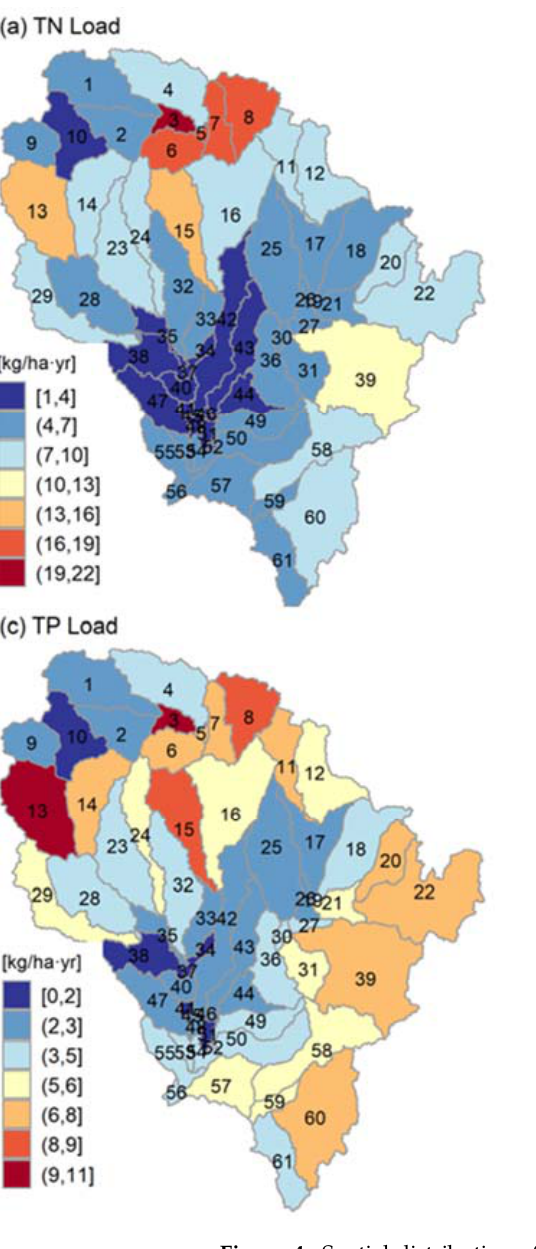
Figure 4. Spatial distribution of simulated TN ( a , b ) and TP ( c , d ) averaged over 2000–2019. Panels ( a , c ) are the annual mean load into reach from each subbasin and ( b , d ) are the mean monthly pollutant concentrations in the reach. The blue palette in ( b , d ) indicates concentrations of water quality of Class I (applicable to source water and national nature reserves, with TN ≤ 0.2 mg/L and TP ≤ 0.02 mg/L), Class II (primary protection zone for centralized drinking water, with TN ≤ 0.5 mg/L and TP ≤ 0.1 mg/L), Class III (secondary protection zone for centralized drinking water, with TN ≤ 1 mg/L and TP ≤ 0.2 mg/L), Class IV (undrinkable, applicable to general industrial water, with TN ≤ 1.5 mg/L and TP ≤ 0.3 mg/L), and Class V (undrinkable, applicable to agricultural water, with TN ≤ 2 mg/L and TP ≤ 0.4 mg/L), respectively, according to Environmental Quality Standards for Surface Water (GB3838-2002). The red palette indicates water quality inferior to Class V (i.e., TN > 2 mg/L and TP > 0.4 mg/L). SWAT simulated nutrient yields are expressed as load. The term was converted from load to concentration to facilitate comparison between simulation, record, and Environmental Quality Standards for Surface Water (GB3838-2002). The total N/P load in surface water is TOT X ( X represents nitrogen or phosphorus), while that leaching from HRU or subbasin